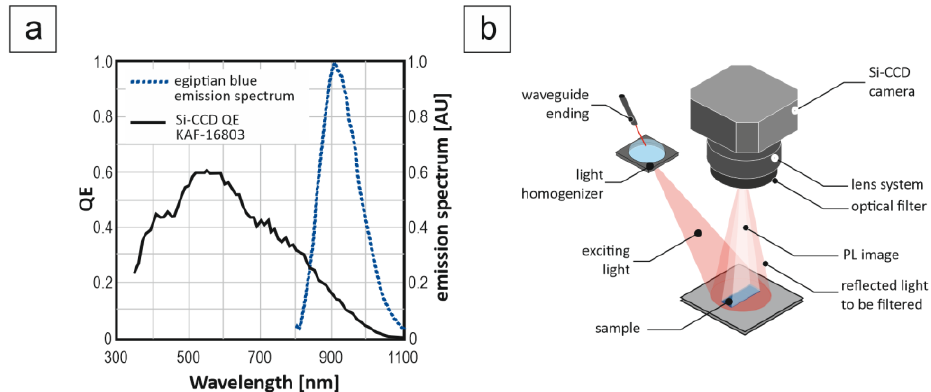
Figure 2. Egyptian blue photoluminescent imaging: ( a ) relation between camera detection spectrum and Egyptian blue emission spectrum (based on Semiconductor Components Industries KAF−16803/D datasheet [21] and Errington [1]), ( b ) measurement system for photoluminescence imaging.